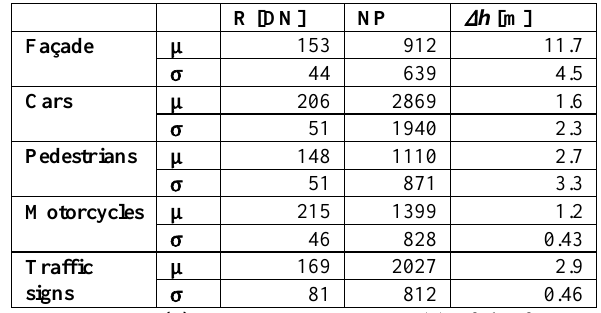
Table 1. Mean (µ) and standard deviation (σ) of the features calculated from the 1,000 training samples per class; R: reflectance value; NP: number of points within cylinder and ∆h height